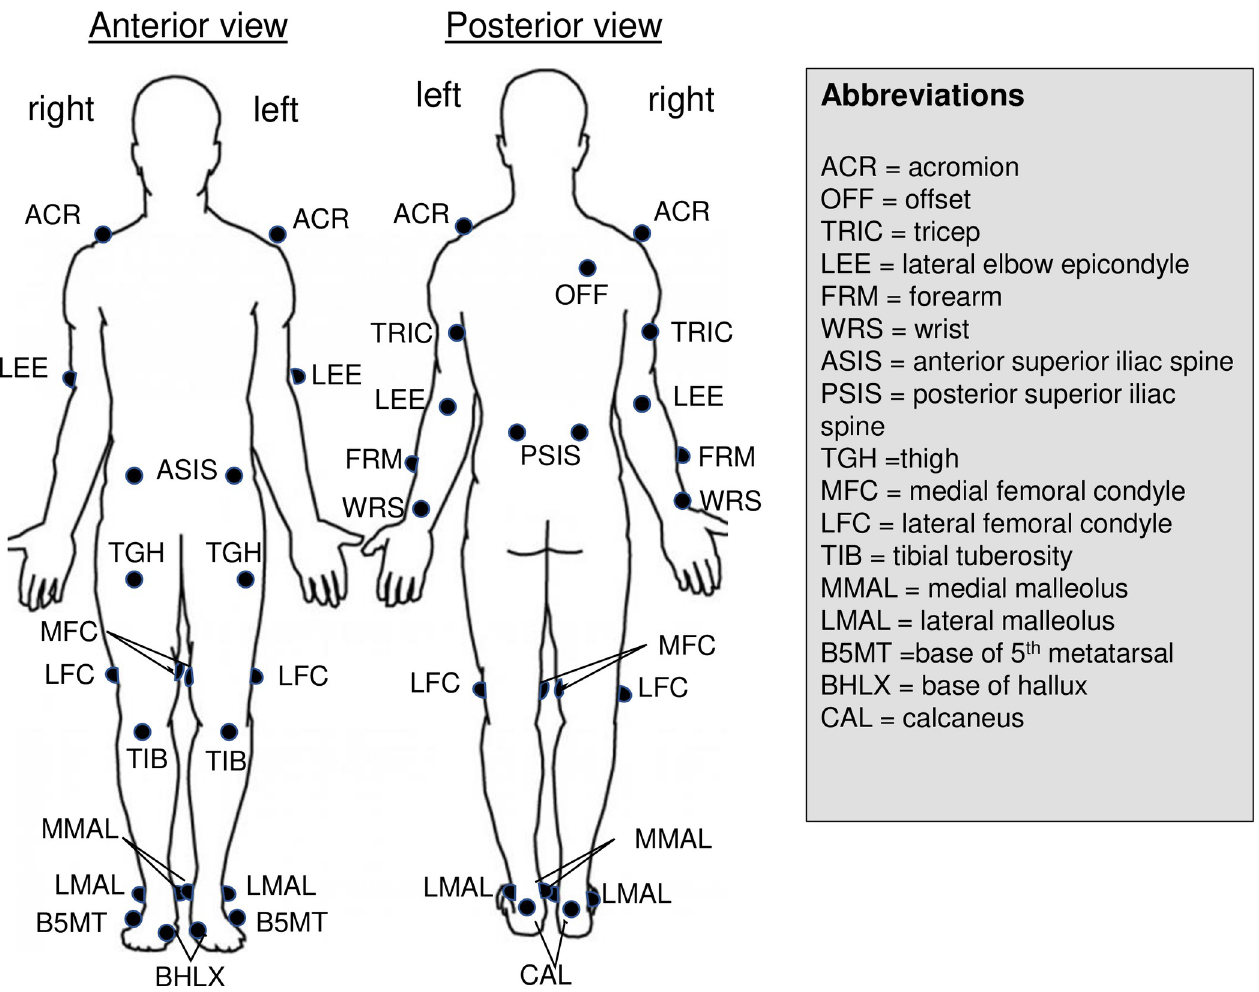
Fig 1. Anatomical placement of retroreflective markers for running